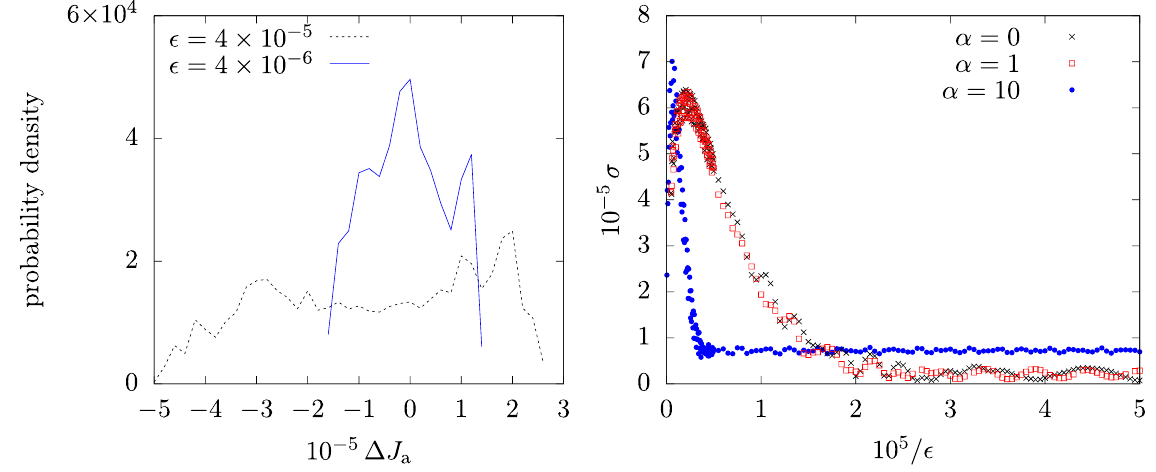
− J and the expected one J ) for α ¼ 10 , for a ; f b a ; i 2 . 602 , ω 2 . 5 , ω 2 . 7 , and a set of x ¼ y ; i ¼ y ; f ¼